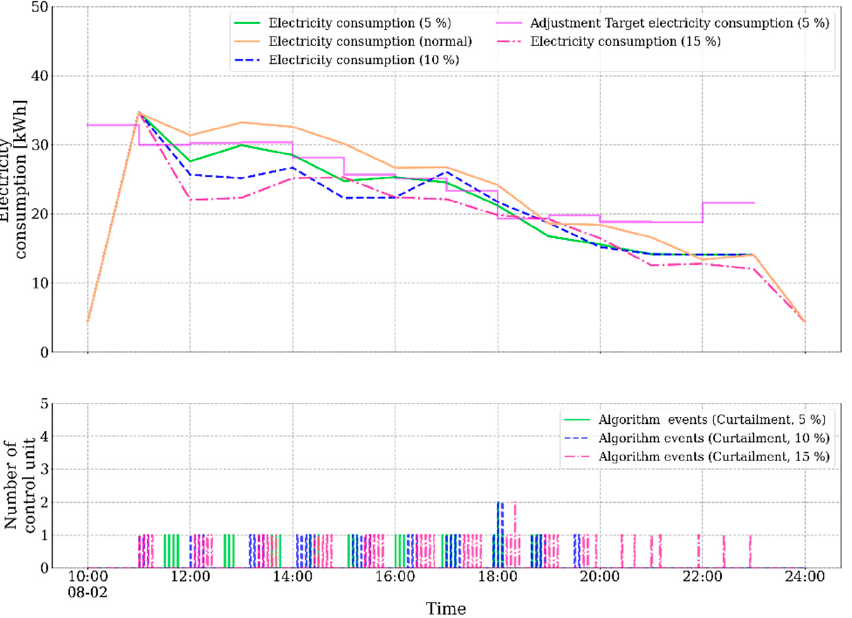
Figure 12. Simulation result with target, building electricity consumption and algorithm event time applying the building control algorithm.